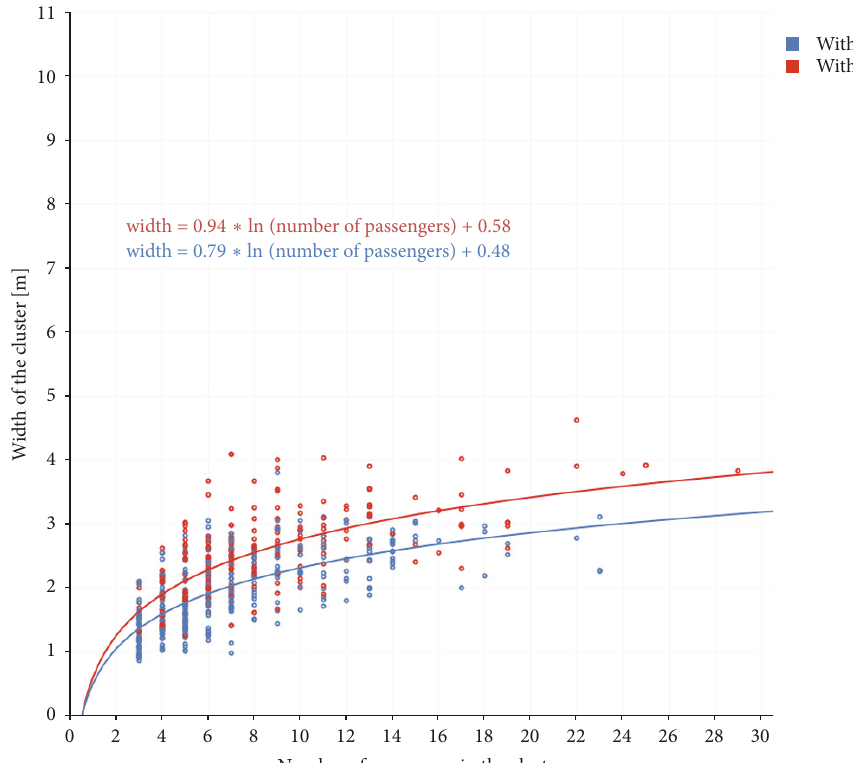
Figure 10: Correlation plot between the width of the clusters (y-axis) and the number of passengers in the clusters (x-axis) according to the presence of